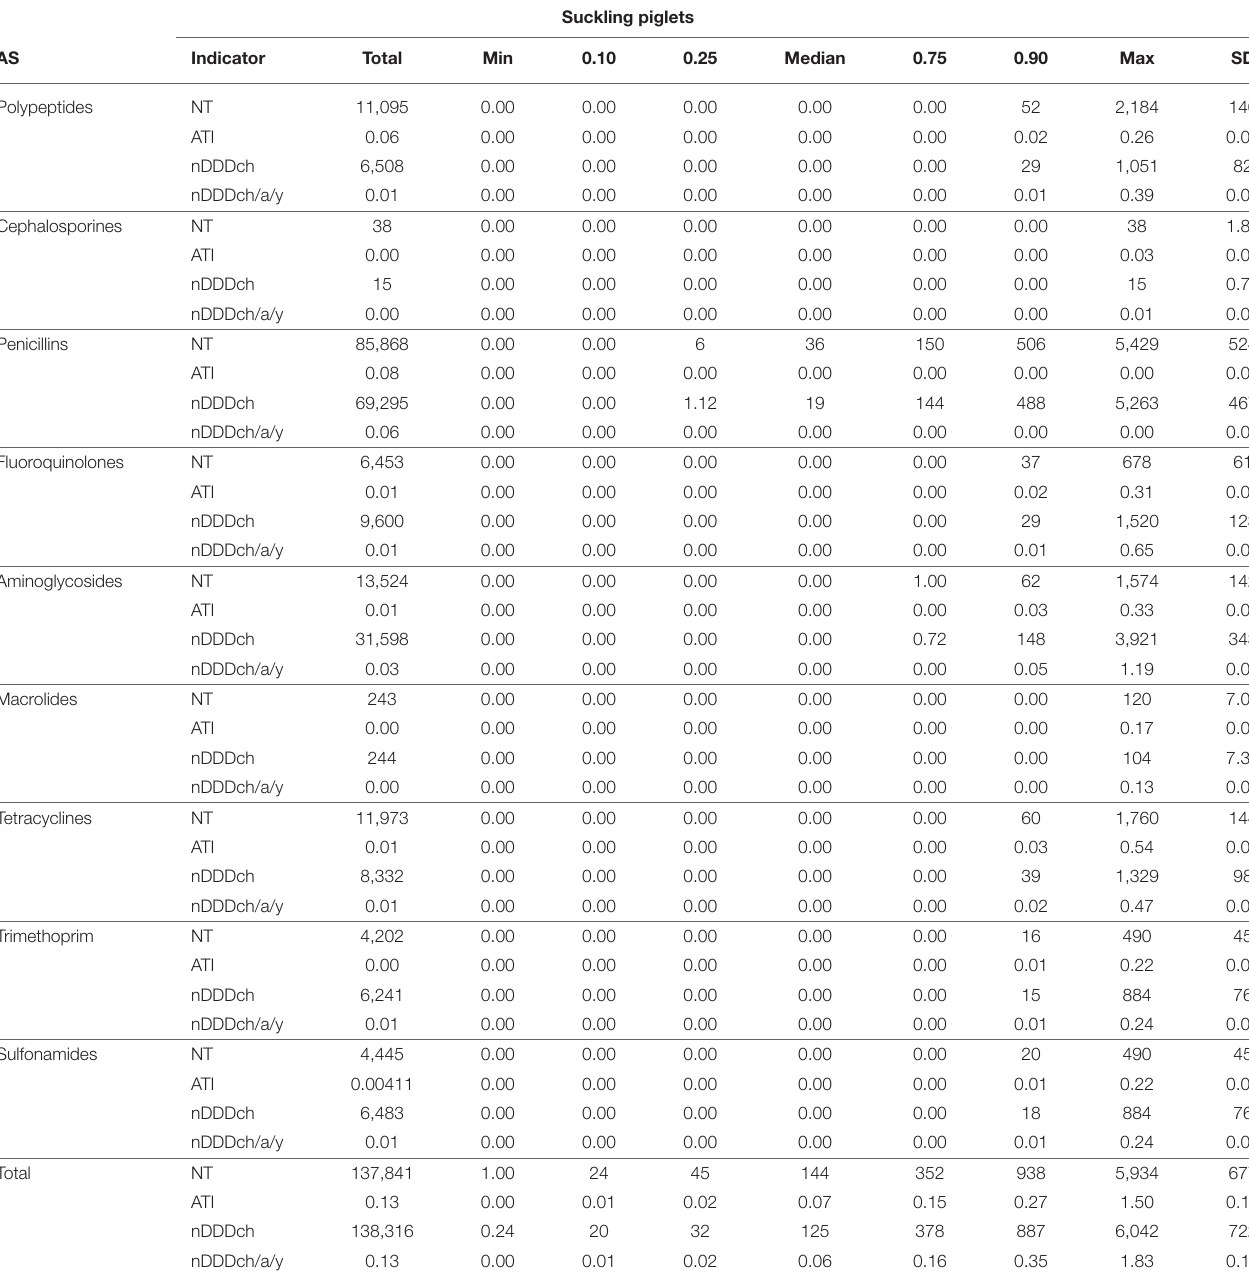
TABLE 2 | Total, minimum (min), median, maximum (max), 10% (0.1), 25% (0.25), 75% (0.75), 90% (0.9) percentiles and standard deviation (SD) of AMU in suckling piglets of the study farms measured using the indicators NT, ATI, nDDDch, and nDDDch/animal/year (nDDDch/a/y) displayed by active substance